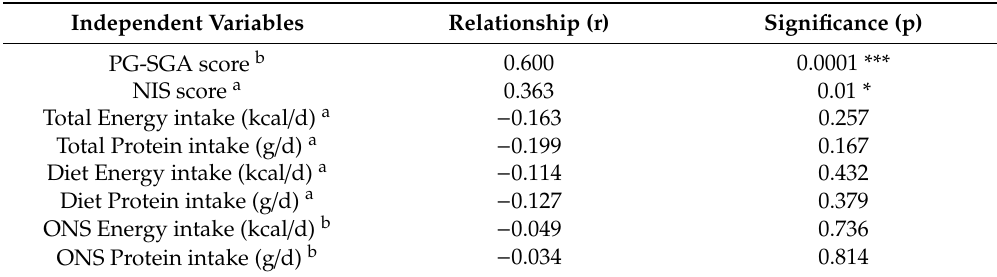
Table 6. Correlation between weight loss percentage and the independent variables ( n =